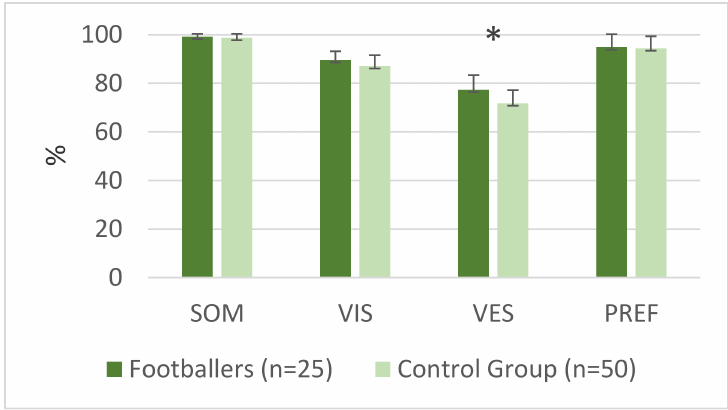
Figure 1. Sensory Organization Test—Composite Equilibrium Score (CES) and Equilibrium Score (ES) results (where the ES su ffi x refers to a particular SOT condition) for footballers and control group. The symbol * refers to a significant di ff erence at p < 0.05.